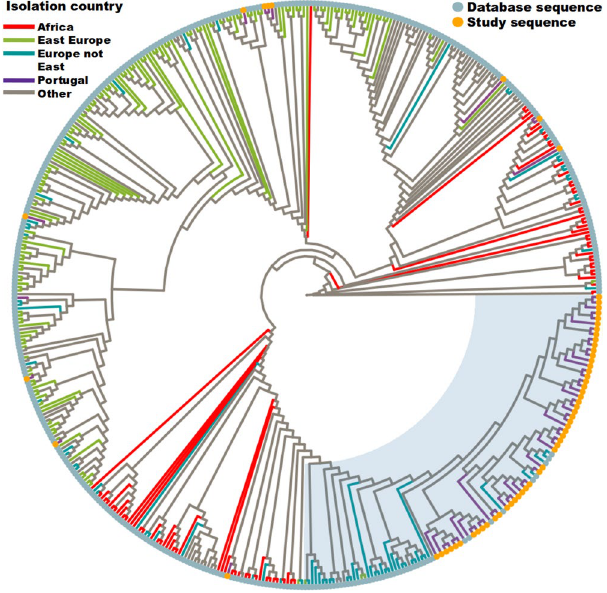
Figure 1. Phylogenetic representation of the A1 sequences isolated in Portugal and closely related sequences from databases. Circular cladogram representation of the Maximum likelihood tree (Supplementary Fig. 1) with the study A1 sequences and the closely related database sequences (n = 490). Branch colours indicate the geographical origin of the sequences. The tip points indicate if the taxa are an A1 sequence from this study or a database sequence. Most of this study sequences cluster together in a well-defined area of the phylogeny (52 of 65), here further mentioned as the main A1 cluster (MA1). The light grey background encompasses the MA1 and closely related sequences used for further analyses (n = 99, aLRT SH-like branch support =